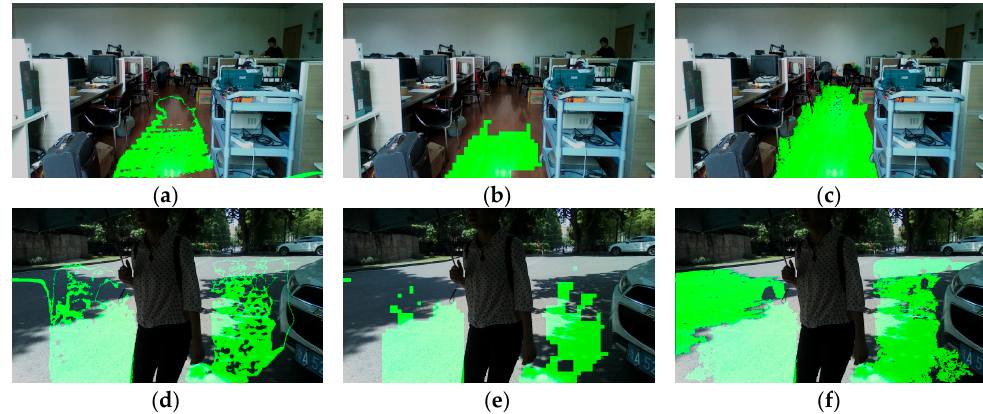
Figure 7. Traversable area expansion in indoor and outdoor environments. ( a , d ) Ground plane detection based on the RANSAC algorithm; ( b , e ) salient parts in the ground plane are dismissed with surface normal vector estimation; and ( c , f ) preliminary traversable area are expanded greatly with seeded region growing.